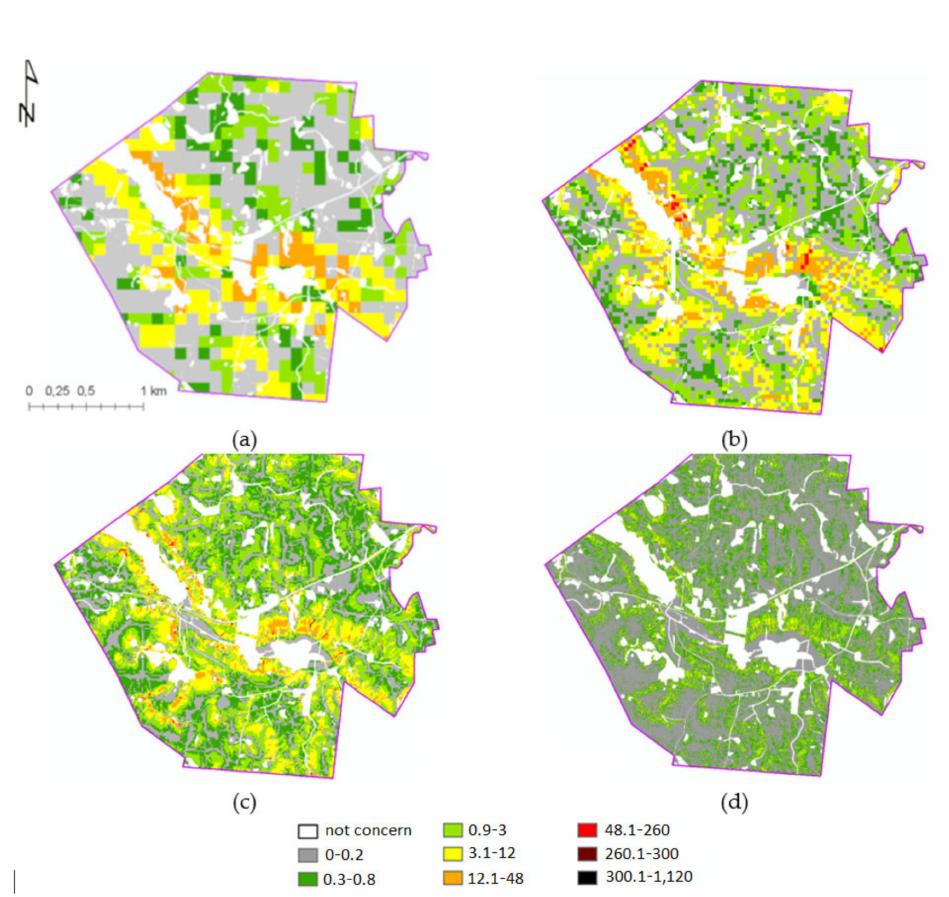
Figure 9. Visualisation of the total LS factor values (classes) based on SRTM ( a ), DTED2 ( b ), LPIS ( c ) and ISOK ( d ) for the Bolcie research area (additional visualisations for Janowice and Winiarki research areas are presented in the Appendix